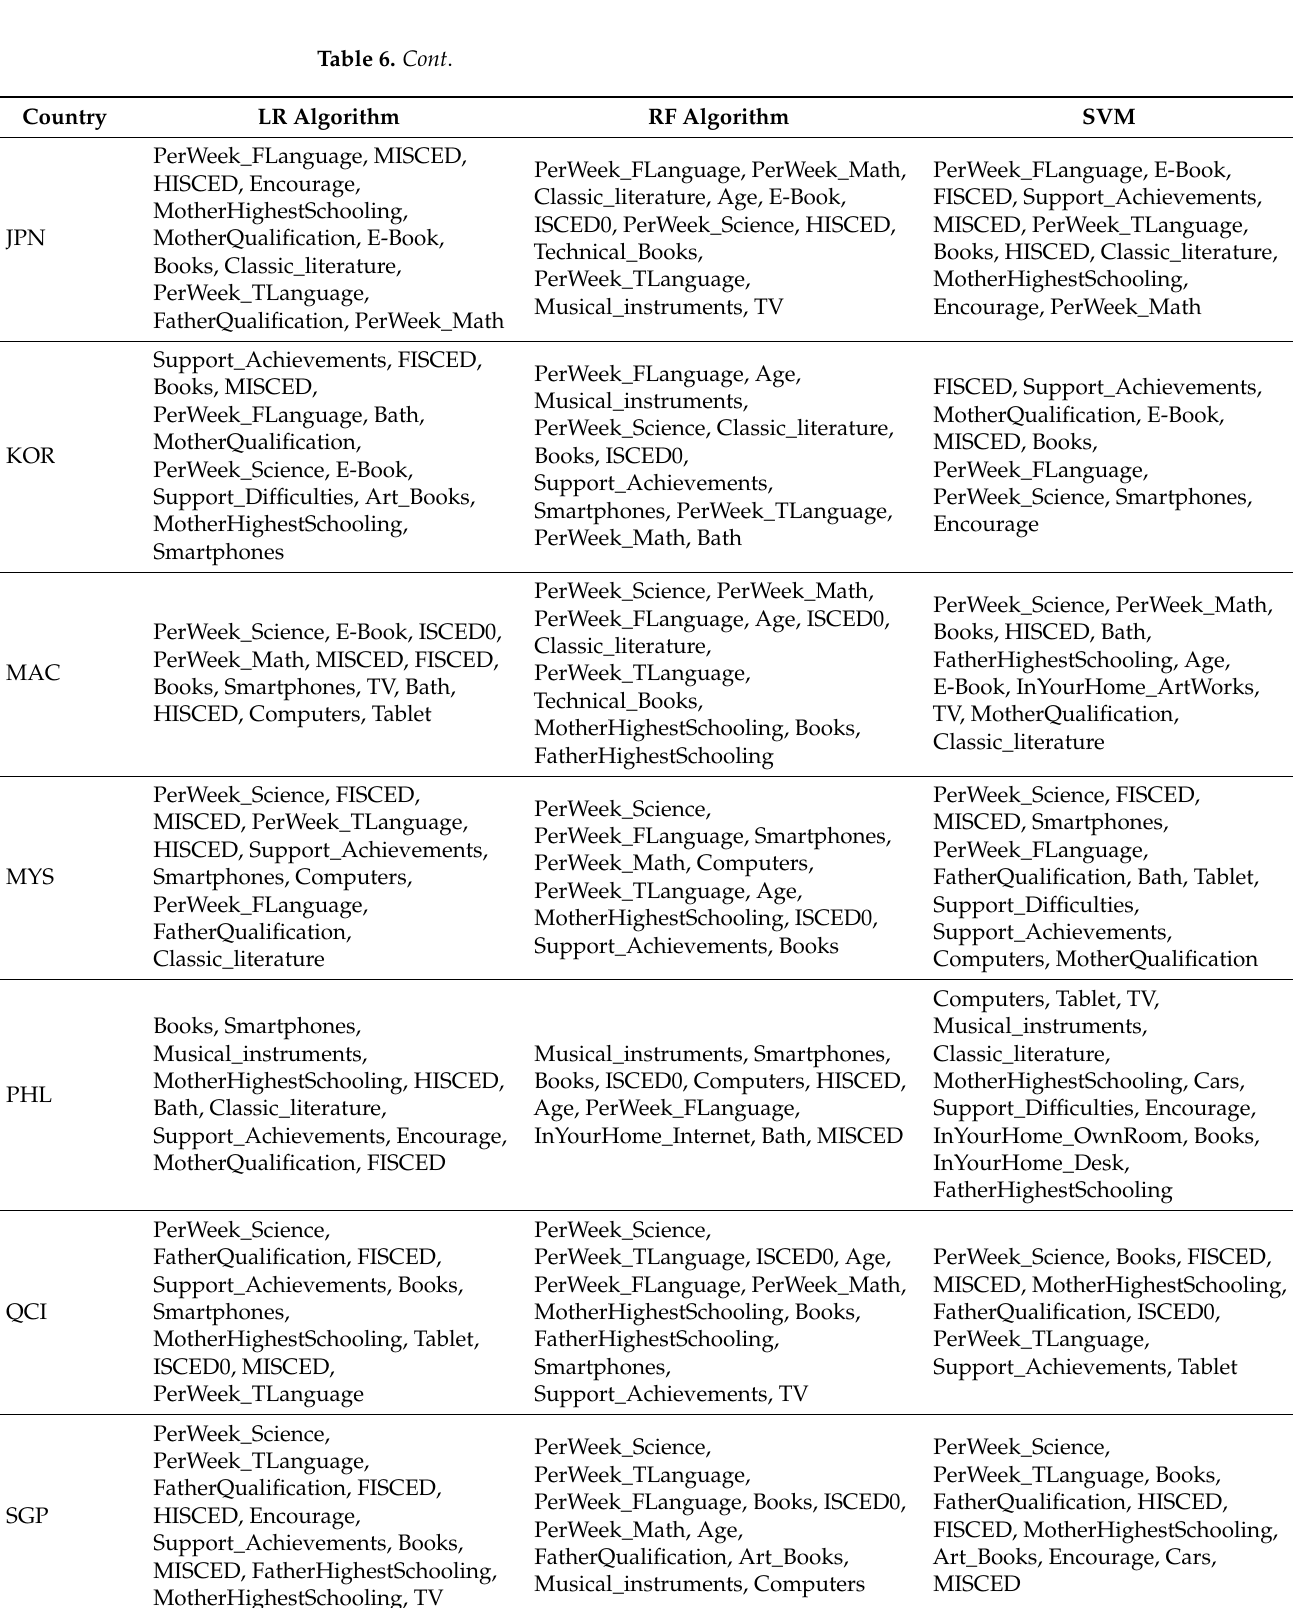
Table 6. Cont . LR